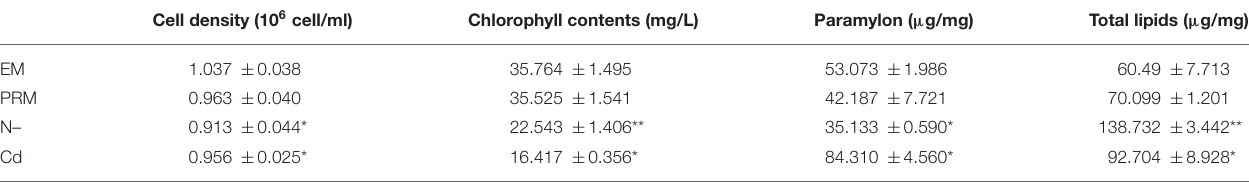
TABLE 1 | Physiological parameter, cell density, chlorophyll contents, paramylon, and total lipids determined under different environmental stresses.